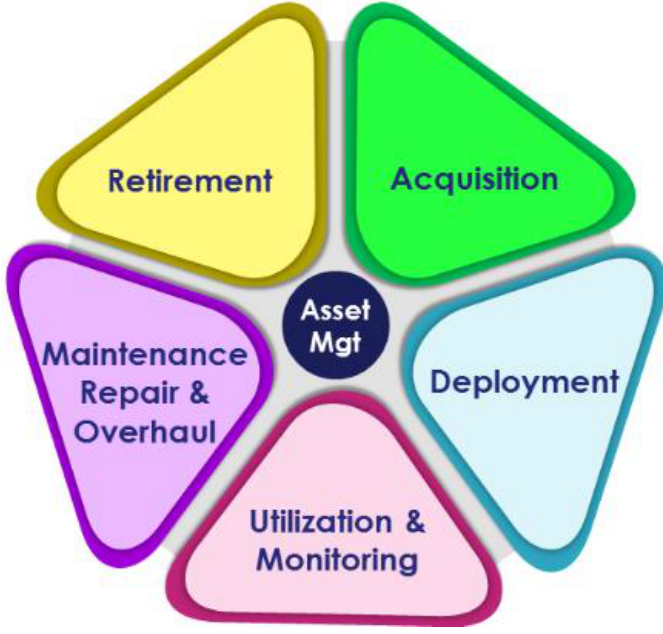
Figure 1. Lifecycle of asset